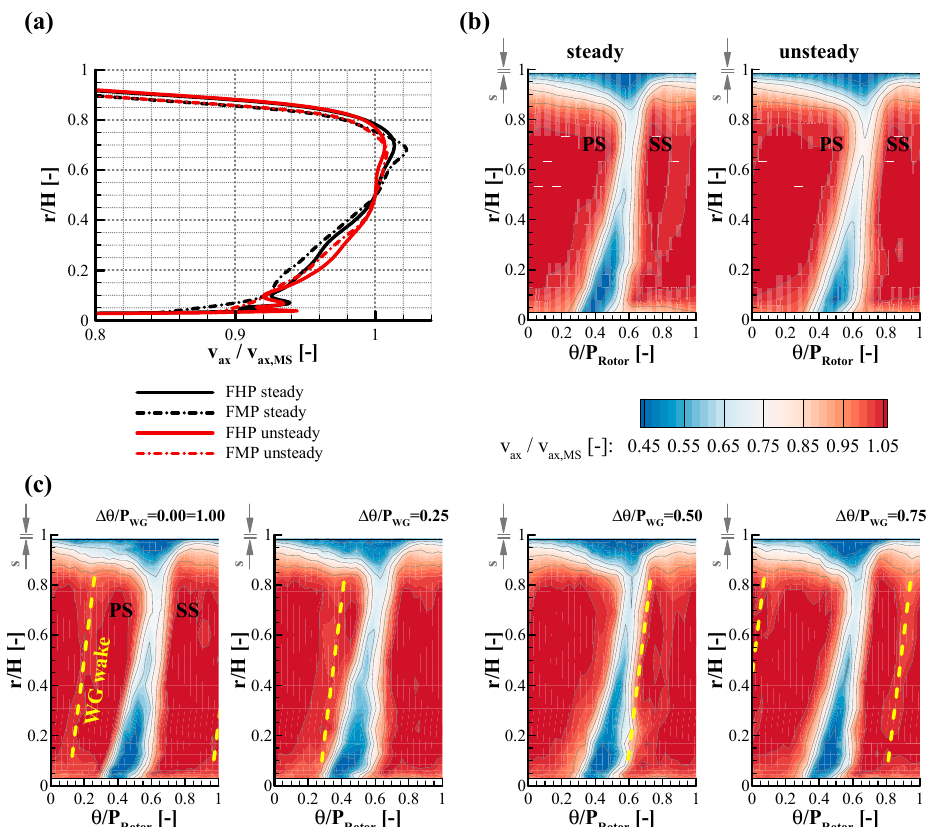
Figure 5. Effect of incoming periodic transient wakes on ( a ) time- and pitchwise averaged data up- (MP3) and downstream (MP4) of R1, ( b ) ensemble- and pitchwise averaged FMP data and ( c ) ensemble averaged FMP data at discrete relative positions between WG and R1 downstream of R1 (MP4), s/C= 1.36%, EXP.